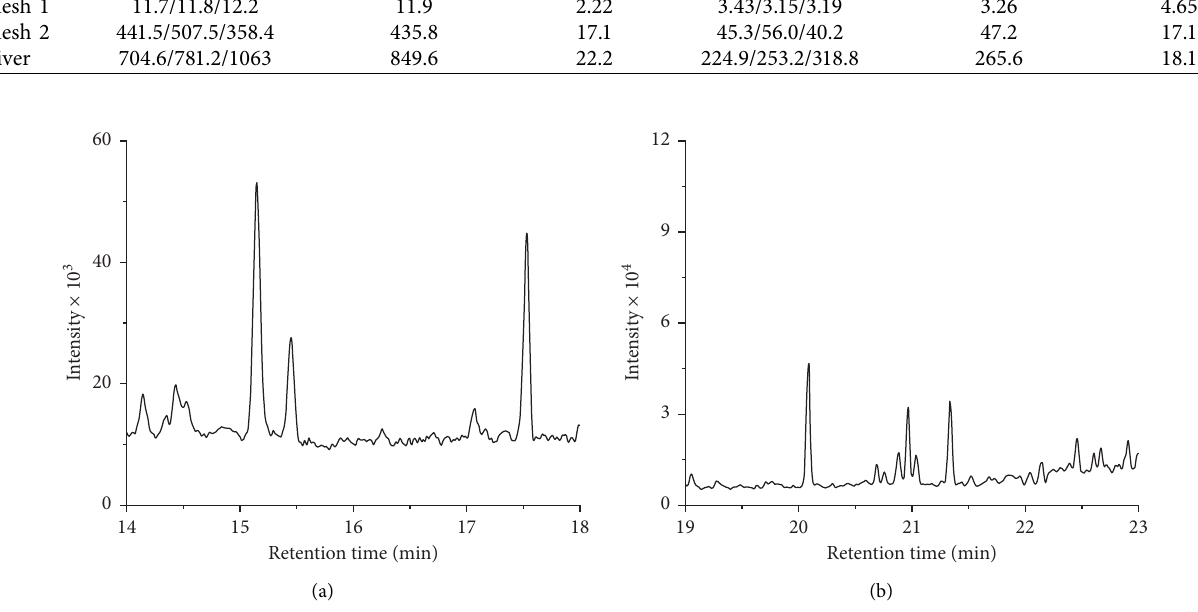
Figure 5: Typical chromatograms of 2-MIB (a) and GSM (b) in incurred grass carp after sample preparation (retention time: 2-MIB, 15.15min, GSM,